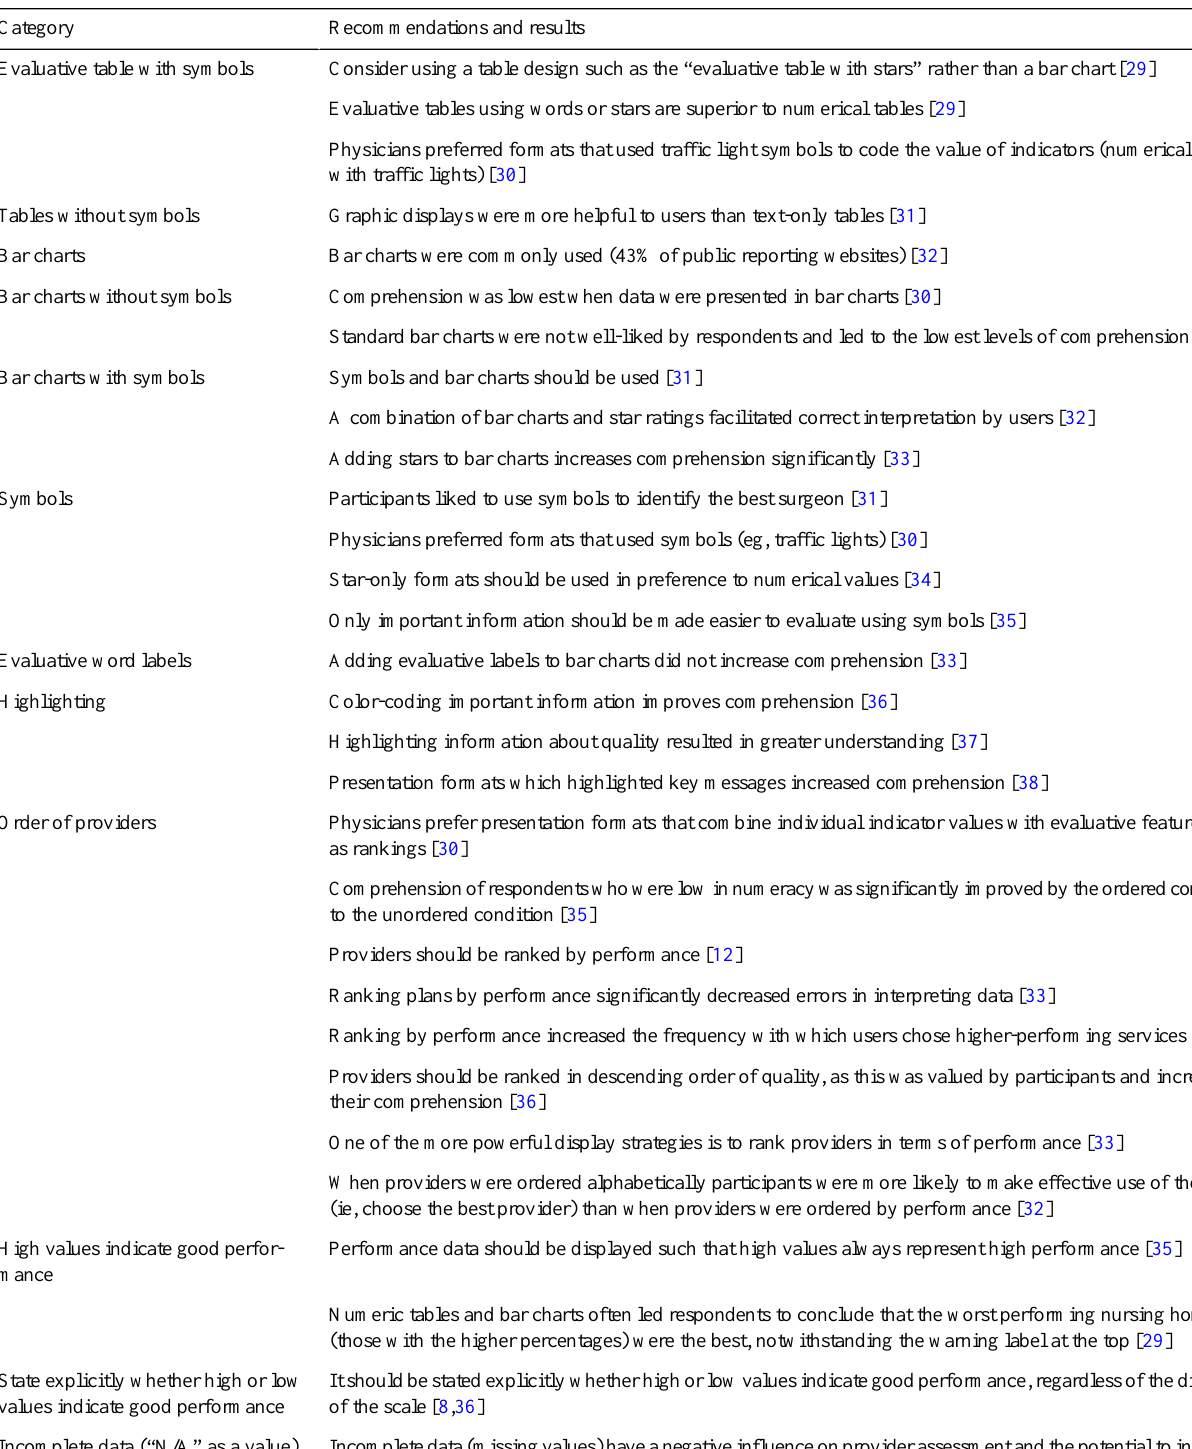
Table 1. Features of the presentation of information on health care report cards from previous studies. Recommendations and